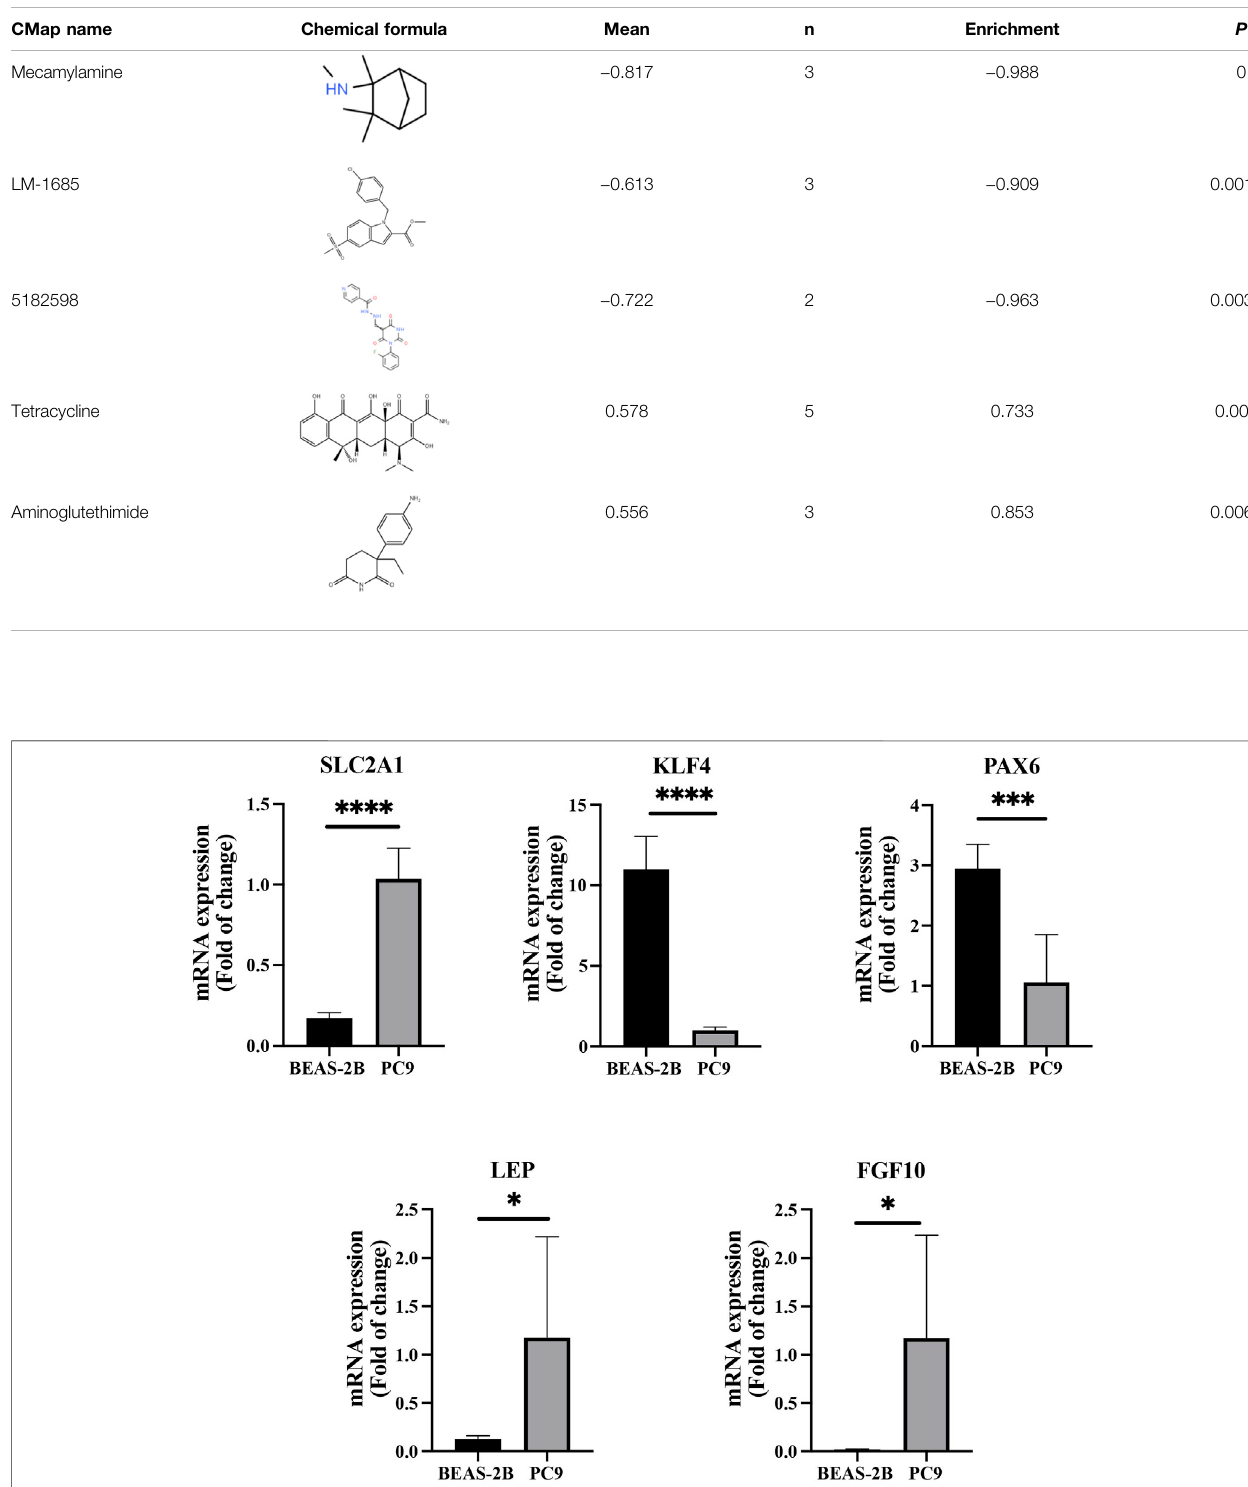
TABLE1 | Five chemicals were predicted as putative therapeutic agents for LUAD.